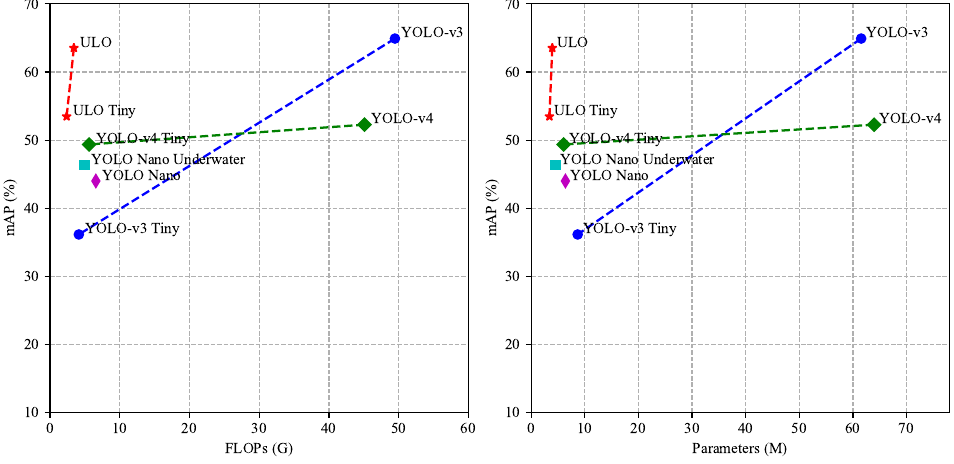
Figure 7. The FLOPs-mAP curve ( left ) and the Parameters-mAP curve ( right ).